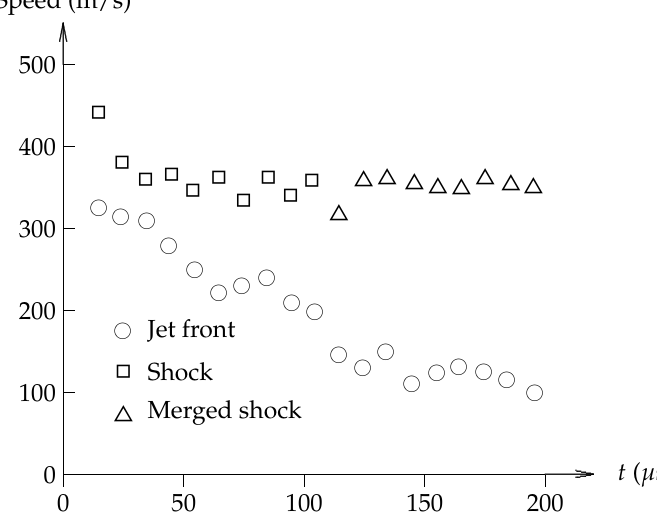
Figure 8. Velocities of jet front and shock.